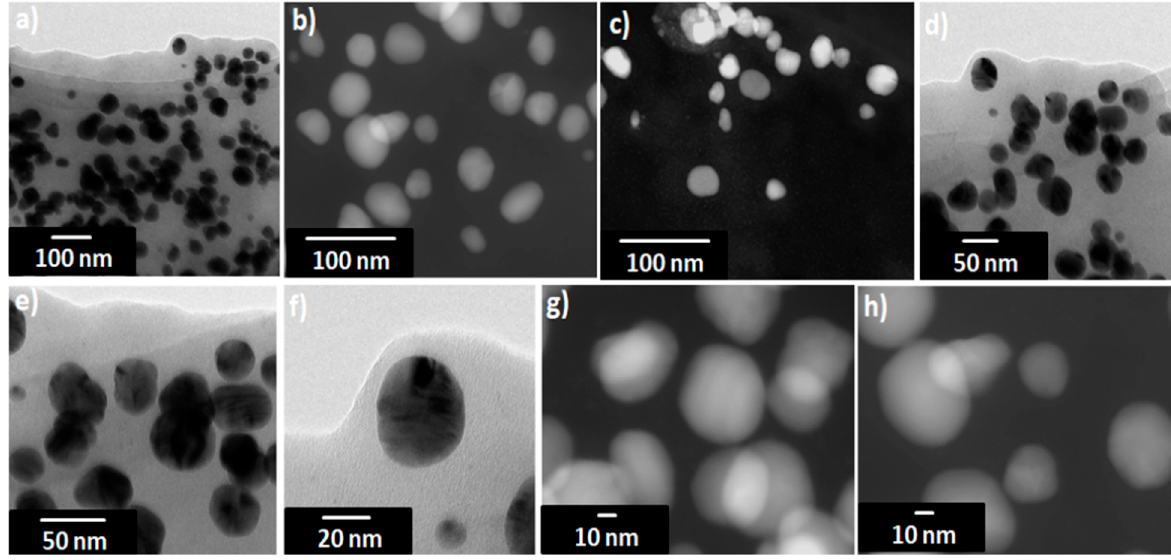
Figure 5. SEM images for the sample 16 at different magnifications, ( a ) 50,000×, ( b ) 100,000×, ( c ) 200,000×, ( d ) 220,000×.